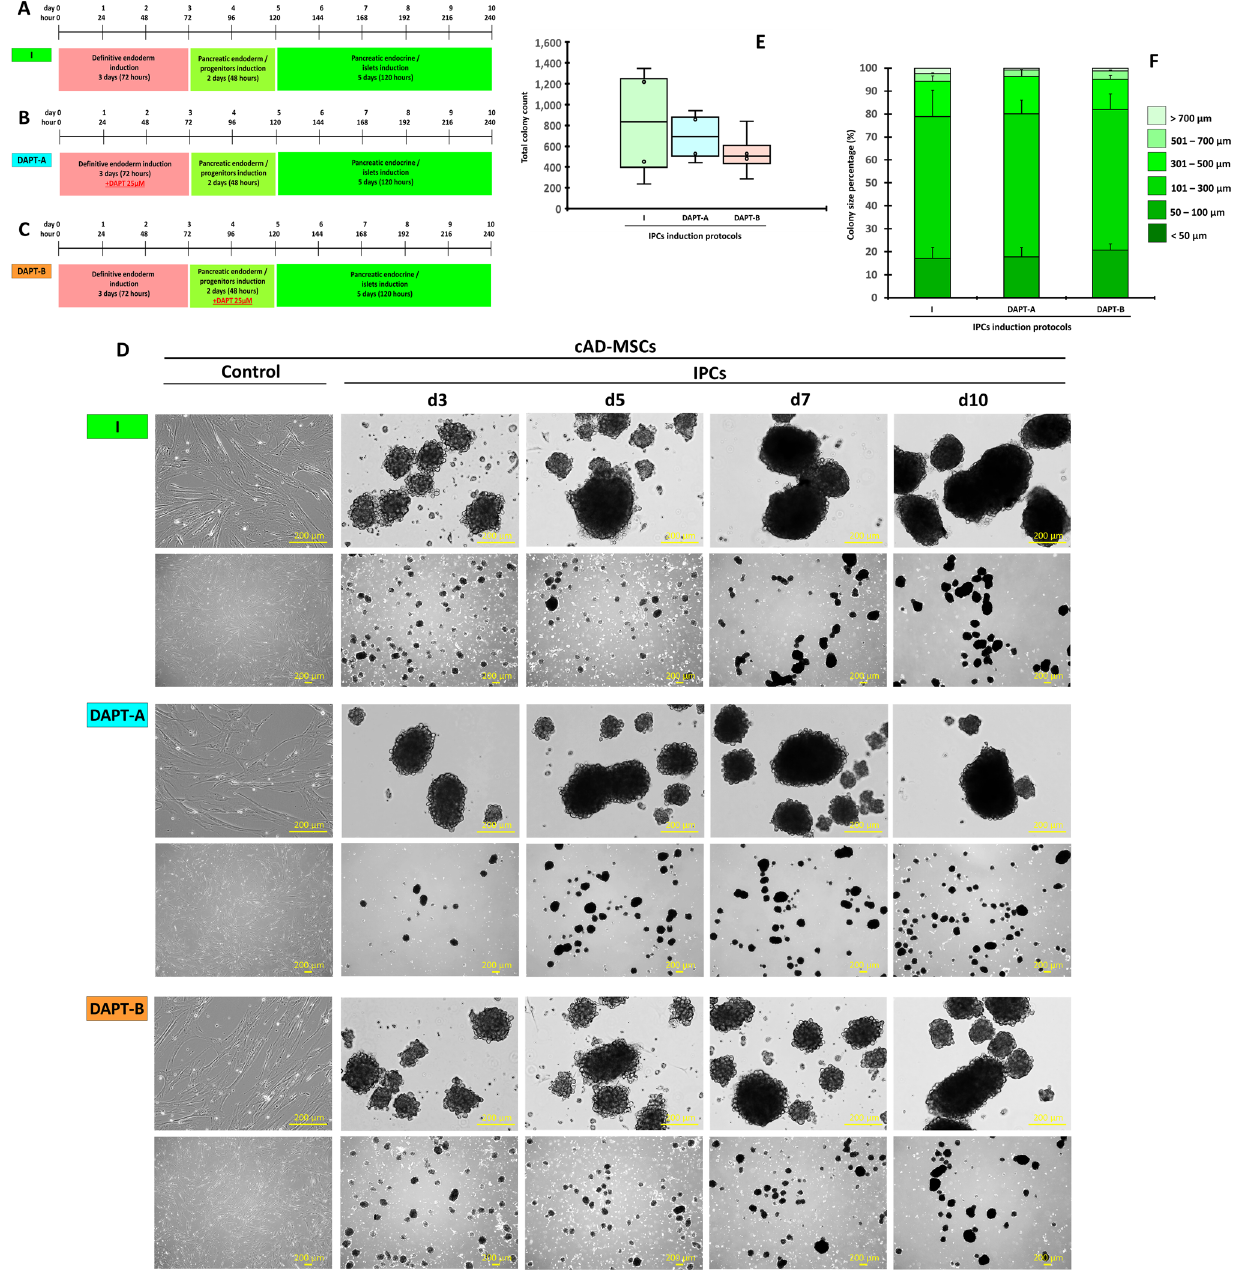
Figure 6. Generation of cAD-MSC-derived IPCs with Notch signaling manipulation. Diagrams of Notch signaling manipulation used for the generation of cAD-MSC-derived IPCs are shown ( A – C ). Morphological appearances of cells that underwent each of induction technique were observed under a phase-contrast microscope with magnification of 40X and 200X ( D ). Total colony number ( E ) and colony size proportion ( F ) were